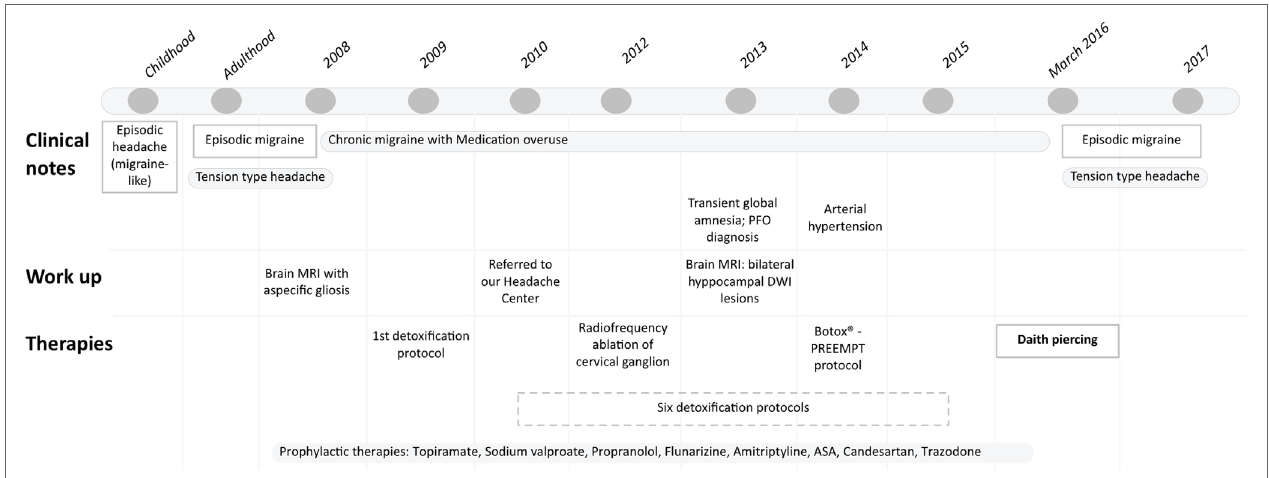
FiguRe 1 | Timeline of patient’s clinical history from childhood to daith piercing